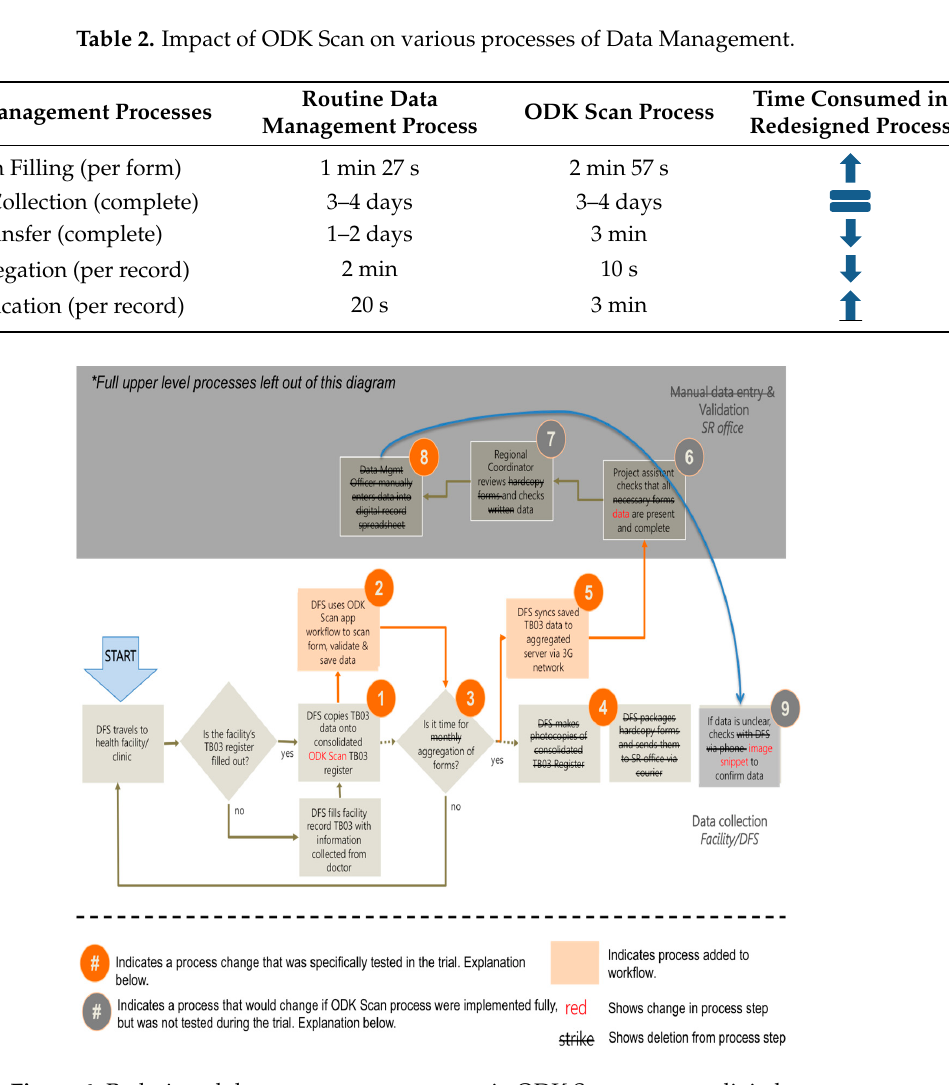
Table 2. Impact of ODK Scan on various processes of Data Management.